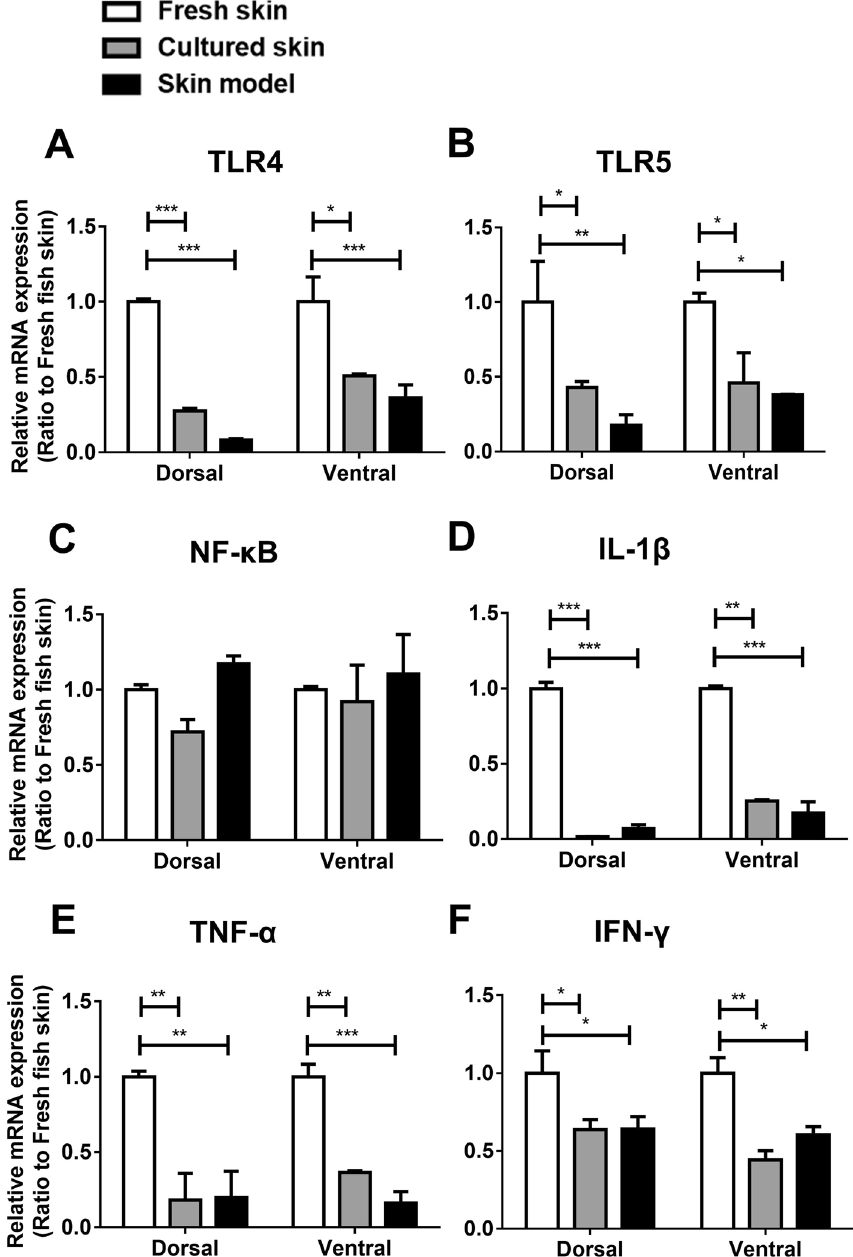
Figure 5. Immune marker mRNA expression in the skin model. The RNA from fresh skin, cultured skin, and skin model were extracted and followed by RT-qPCR for mRNA expression. The mRNA expression level of ( A ) TLR4, ( B ) TLR5, ( C ) NF-κB, ( D ) IL-1β, ( E ) TNF-α, ( F ) IFN-γ in cultured skin and skin model are relative to the expression of fresh skin. All data were shown as mean values (± SEM). Four fish and two replicates of tissue